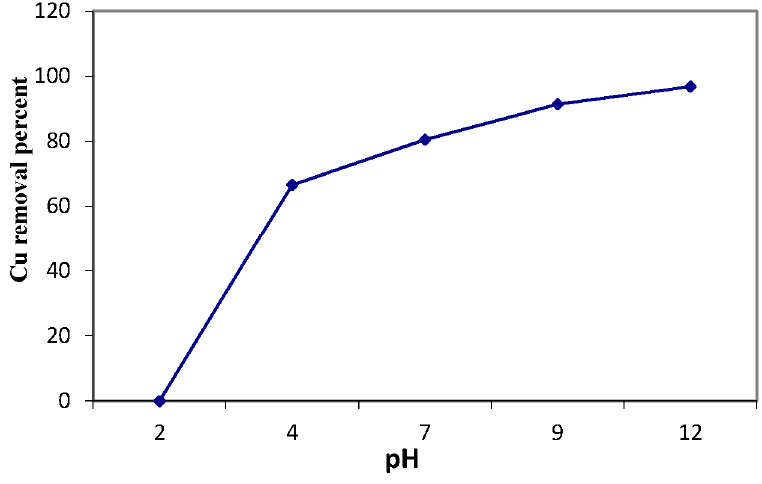
Figure 12. Effect of copper solution pH on the copper sorption process using MANSG (solution concentration of ion = 1000 ppm; amount of MANSG = 0.25 g; agitation speed = 200 rpm; solution volume = 25 mL; time = 90 min).